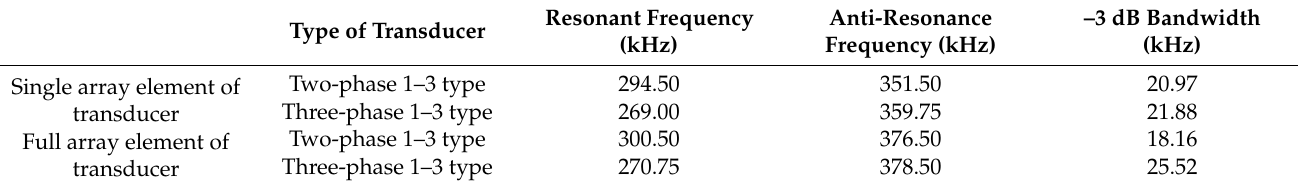
Figure 13. Underwater impedance-phase of single element and full array of the planar array transducer. ( a ) Two kinds of transducer single array element impedance-phase curves in water; ( b ) Two kinds of transducer full array impedance-phase curves in water. Table 2. Performance test results of the two transducers in